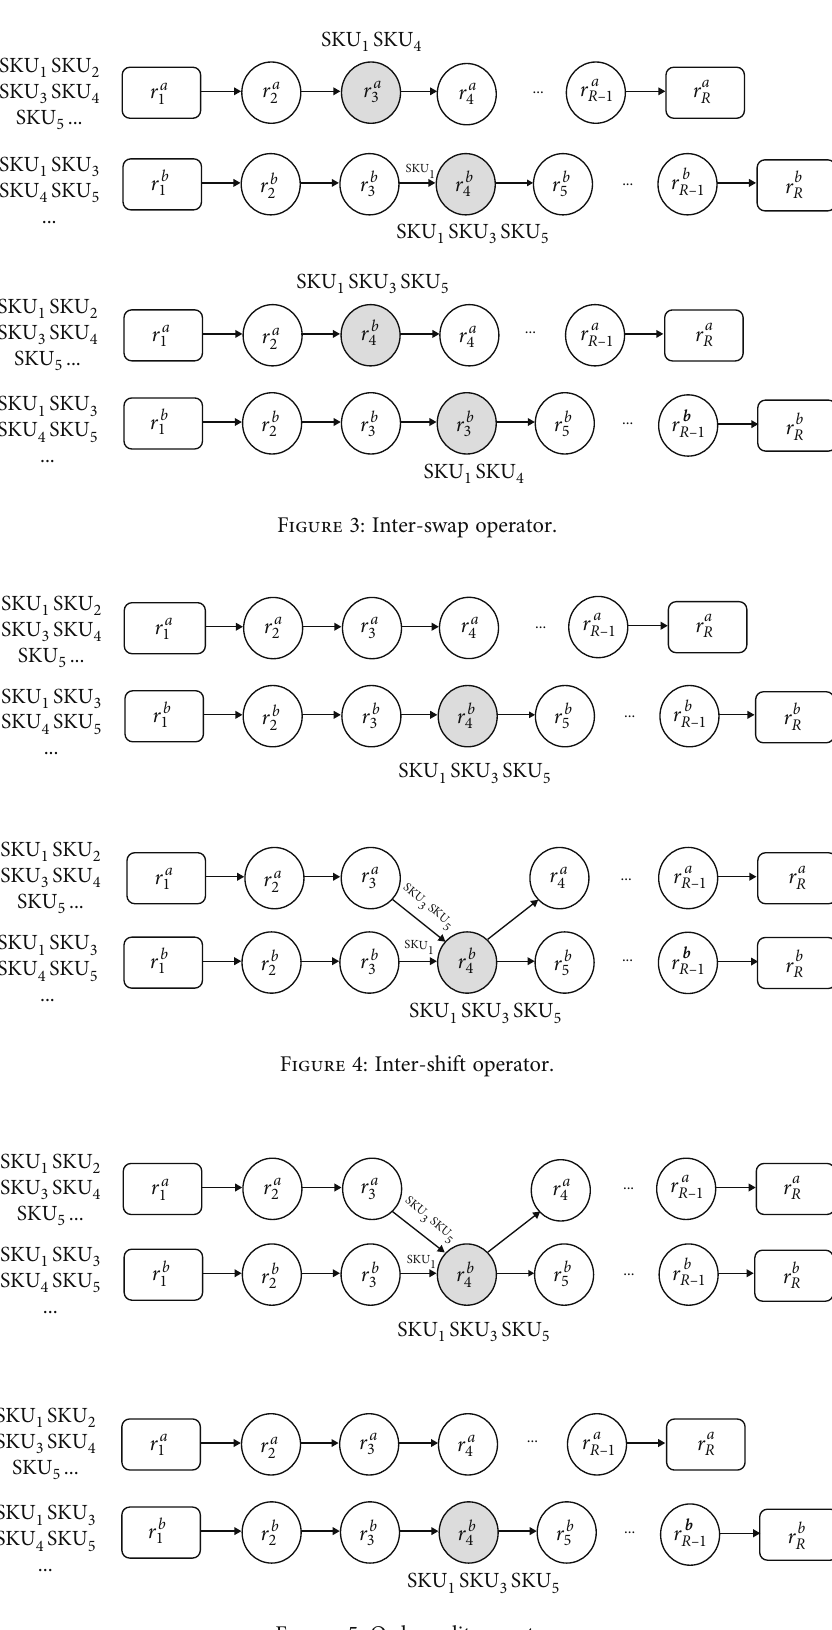
Figure 5: Order-split